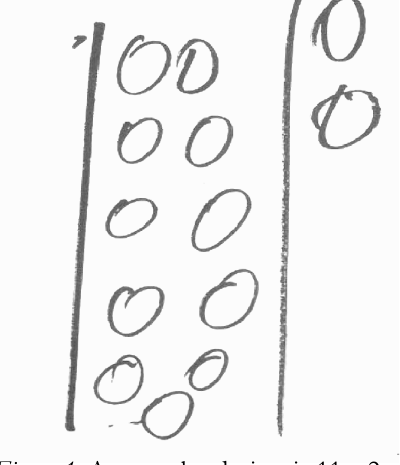
Figura 1. As parcelas desiguais 11 e 2. Psicologia: Reflexªo e Cr(cid:237)tica, 2004,